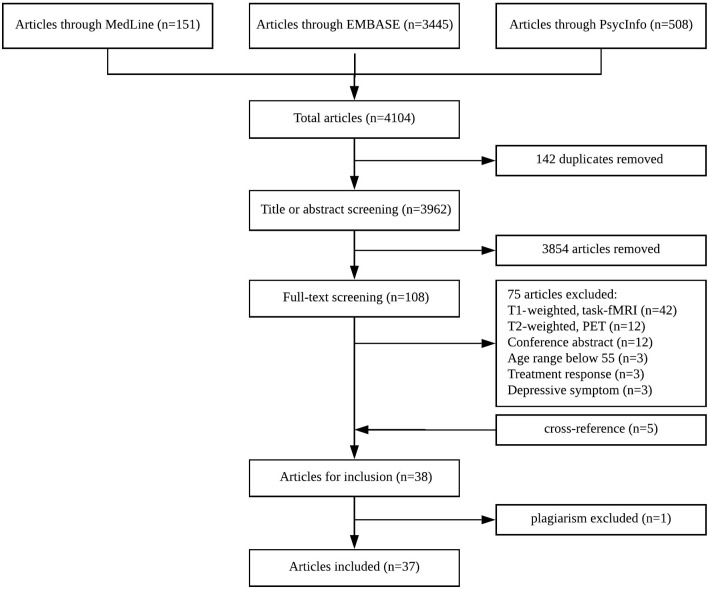
PRISMA flowchart.